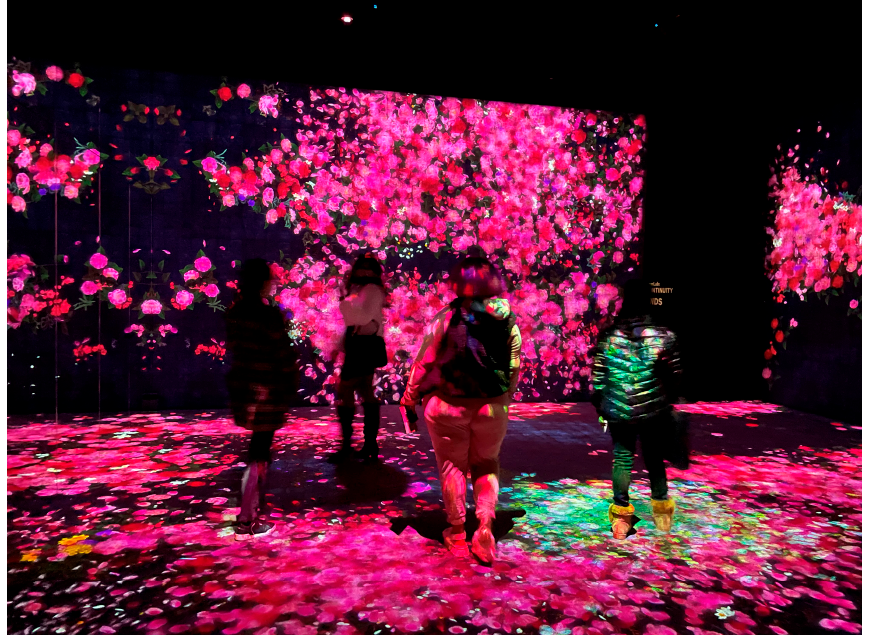
Figure 2. teamLab, Forest of Flowers and People: Lost, Immersed and Reborn, 2017/2021 and Flutter of Butterflies Beyond Borders, Transcending Space, 2019/2021, Asian Art Museum of San Francisco; photograph by the author, 2022.